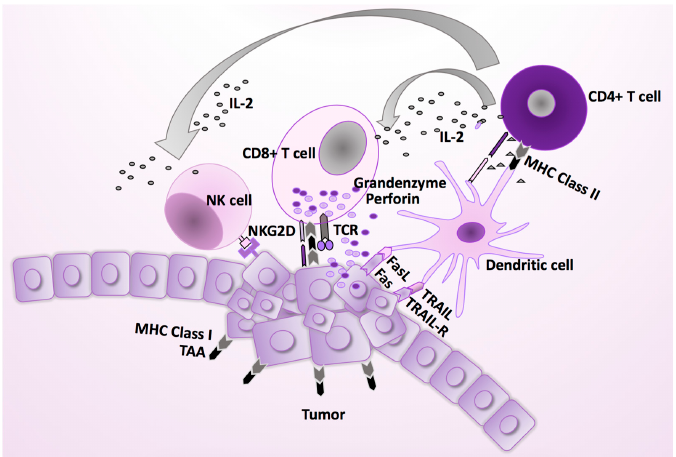
Figure 2 . The normal immune response against virus infections. Cytotoxic CD8+ T cells (CTLs) are effector cells, which display a critical role in the immune defense against intracellular pathogens, including HCMV, and in tumor surveillance. They can recognize viral or mutant cellular peptides presented by MHC class I molecules on their target cells, and exclusively eliminate the virally infected or malignant cells. Their function is supported by antigen specific CD4 + T cells, which are activated